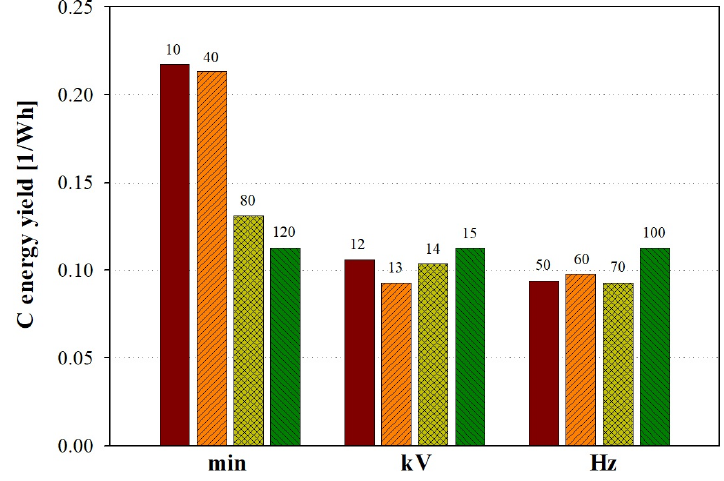
Figure 12. C energy yield graph under various conditions.